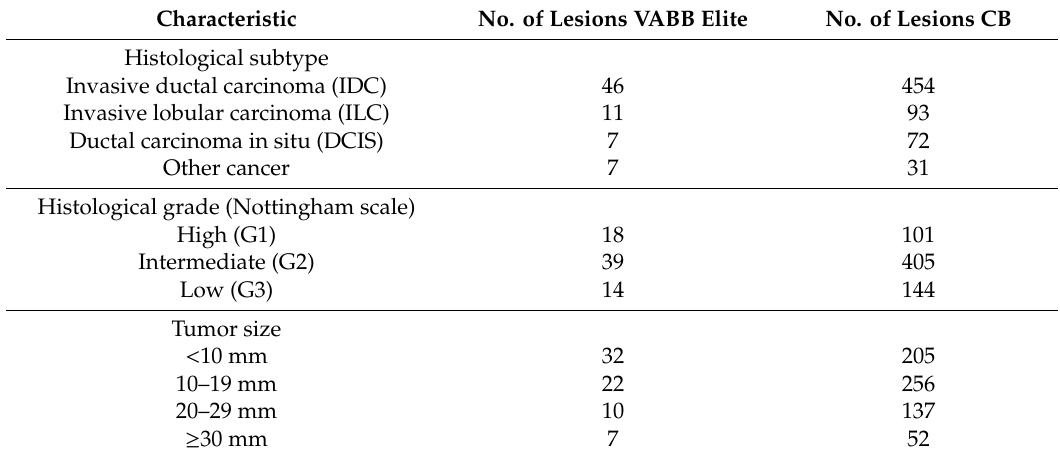
Table 1. Characteristics of the tumors analyzed using the Elite VABB and CB